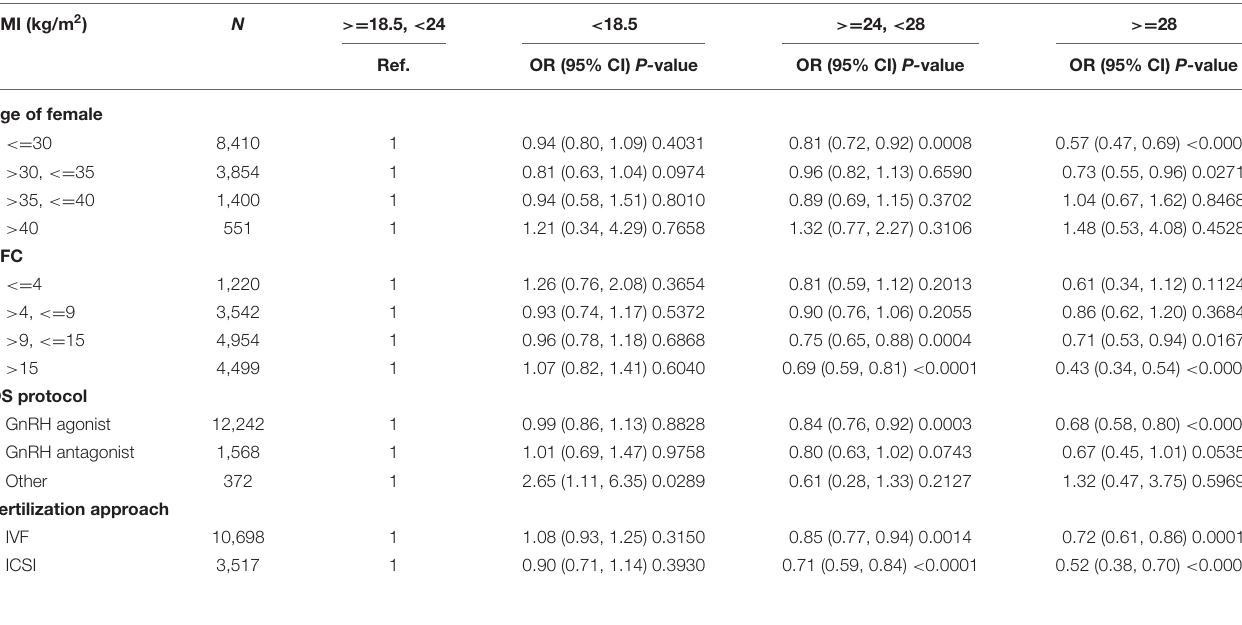
TABLE 5 | Subgroup analysis of CLBR according to AFC, maternal age, and stimulation